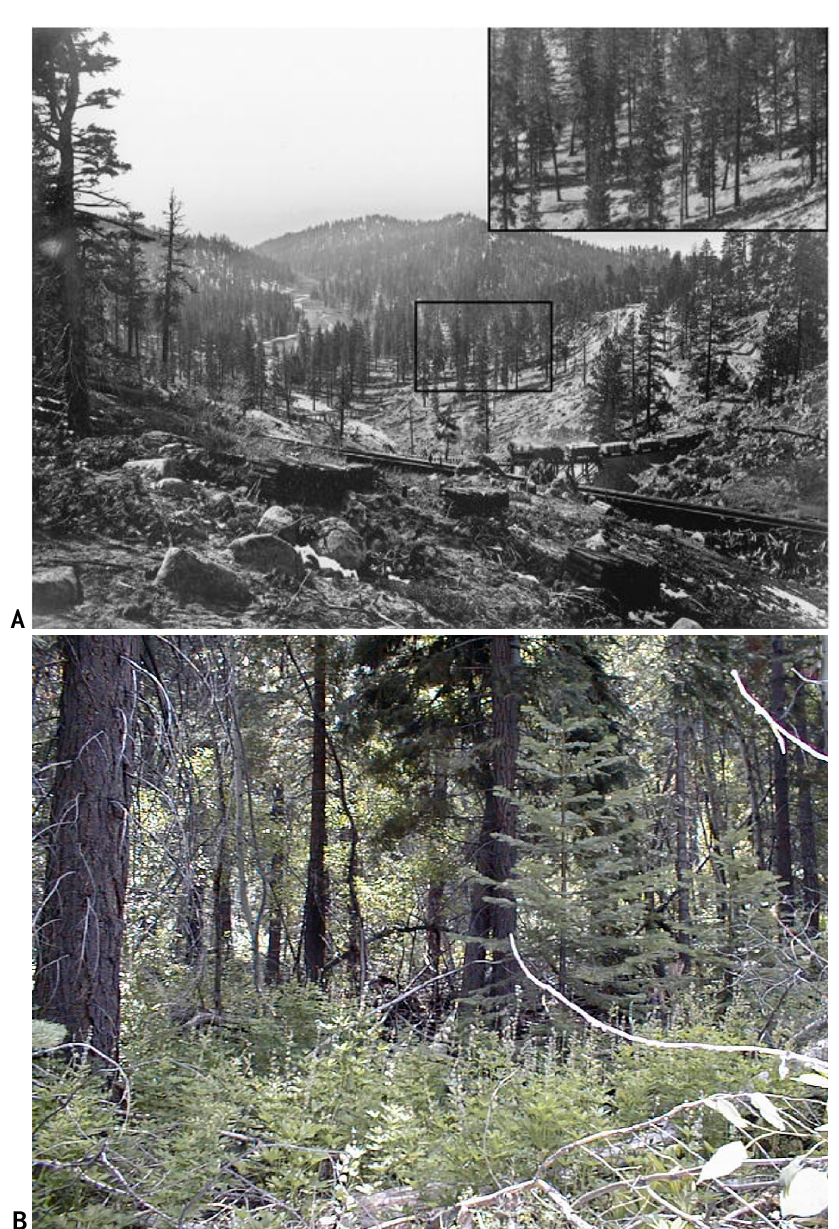
Figure 1. (A) Historic forest conditions depicting open tree stands with sparse understory (reprinted from [24]; (B) Current conditions of closed canopy and heavy